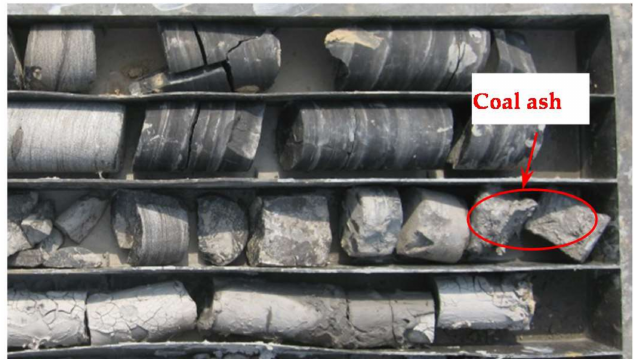
Figure 15. Picture of core-drilling.